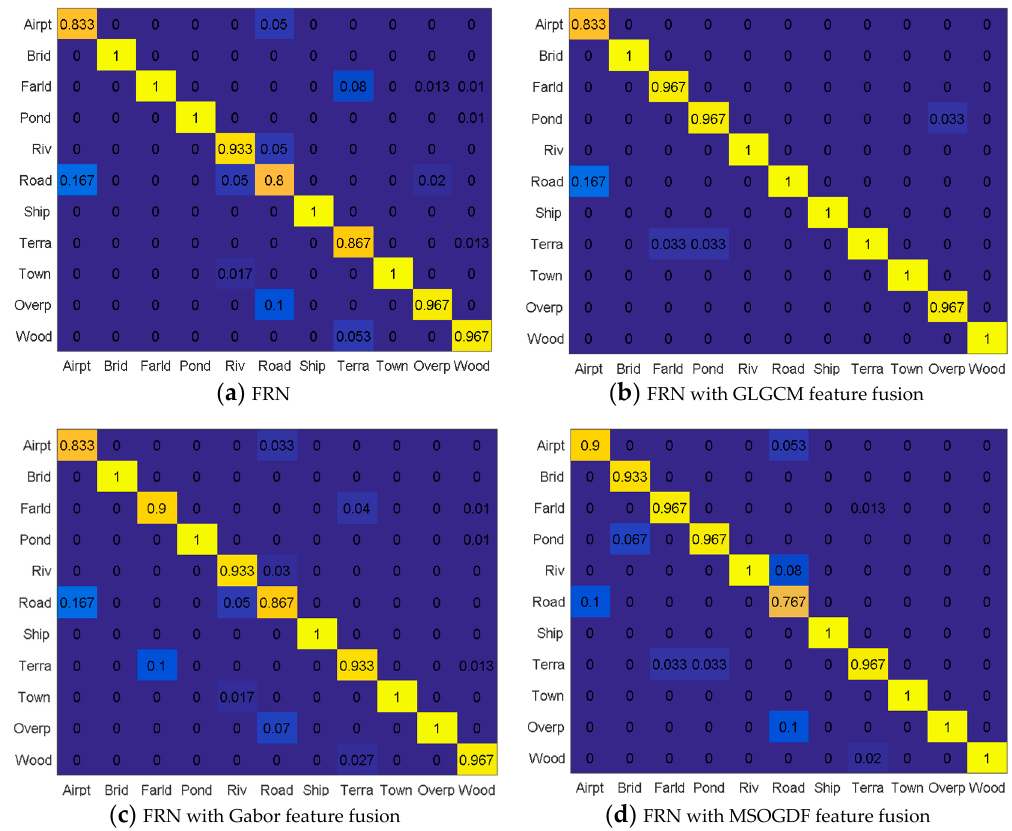
Figure 9. The confusion matrix of different methods for 11 types (‘Airpt’ means Airport, ‘Brid’ means